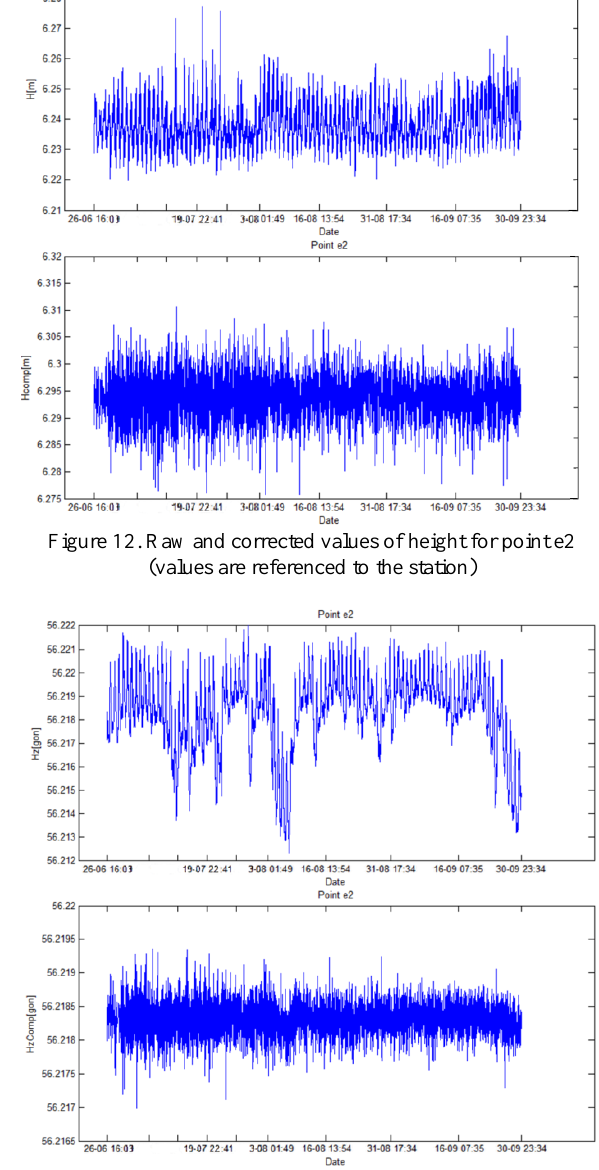
Figure 13. Raw and corrected values of horizontal angle for point